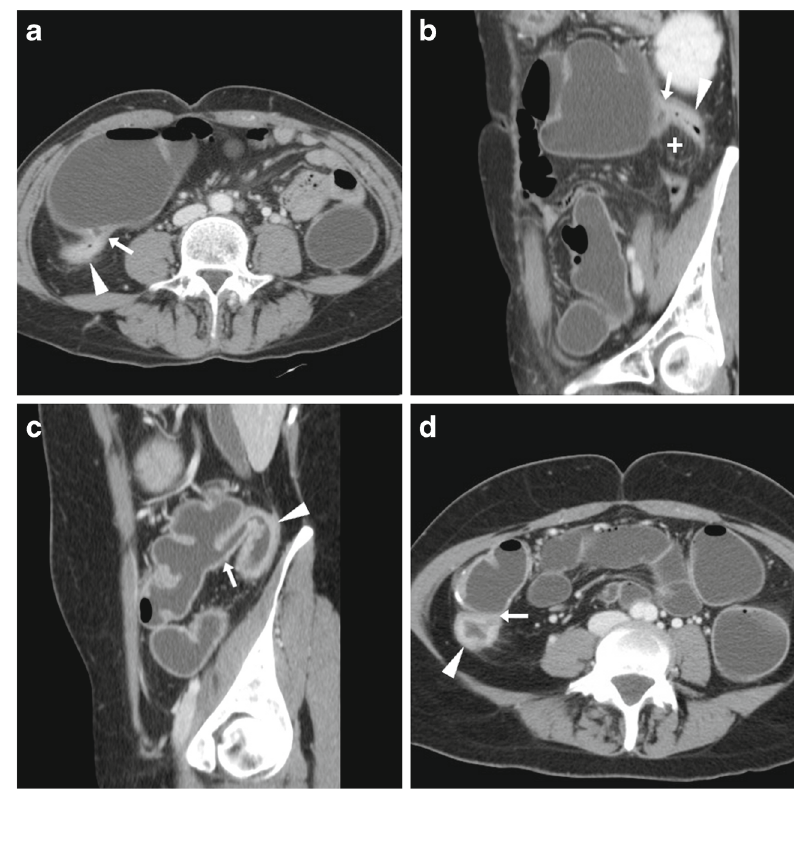
Fig. 15 Differentiation between CD recurrence at the ileo-colic anastomosis (arrowheads in a – b with similar appearance to Fig. 15) and fibrotic stricture at the site of previous sigmoid colon \resection (arrow in c , note similarity with Fig. 9): the latter was treated with balloon dilatation under fluoroscopy ( d